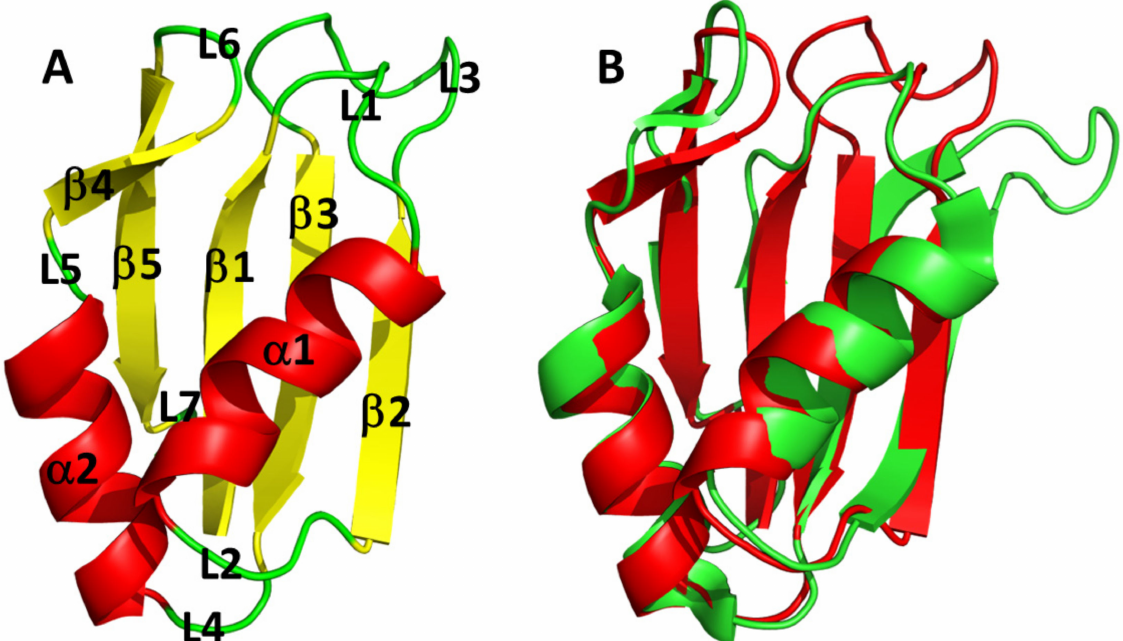
Figure 4. AB-Elavl protein structure. ( A ) Ribbon representation of the three-dimensional structure of the bacterial hypothetical HuR RRM domain. The secondary structural elements and loops have been annotated: helices ( α 1– α 2), strands ( β 1– β 5), loops (L1–L7). ( B ) Superposition of the crystal structure of the bacterial hypothetical HuR RRM domain (rAB-Elavl, red) and 1FLX